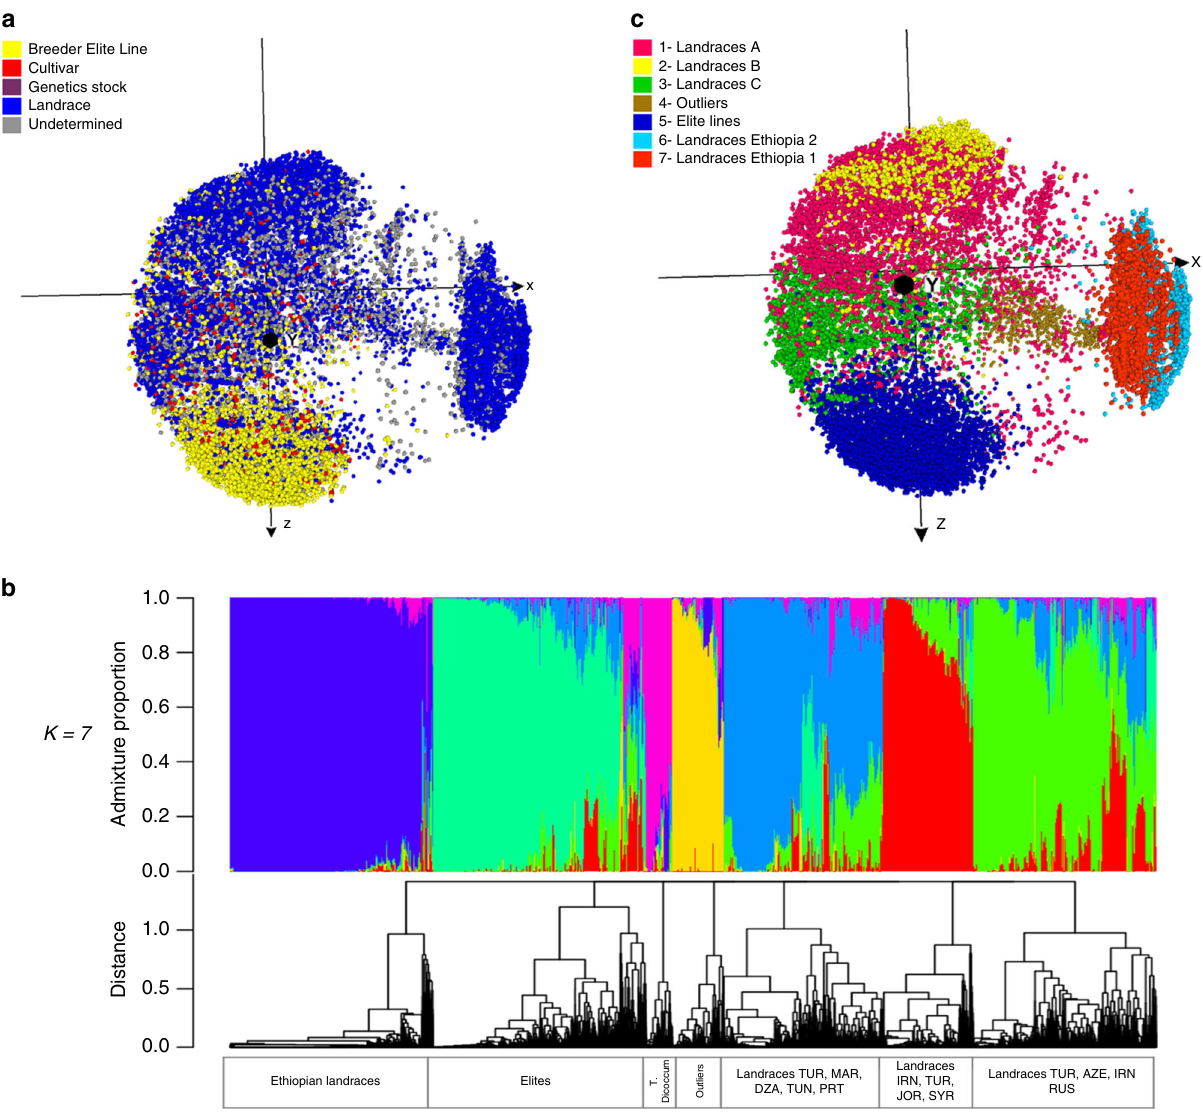
Fig. 2 Diversity analysis of domesticated tetraploid accessions. a Multidimensional scaling plot visualized in Curlywhirly of 18,946 domesticated tetraploid accessions with 30,806 SNP markers differentiated by biological status based on passport information; b ADMIXTURE ancestry coef fi cients ( k = 7) and its dendrogram; c tetraploids distributed in seven clusters based